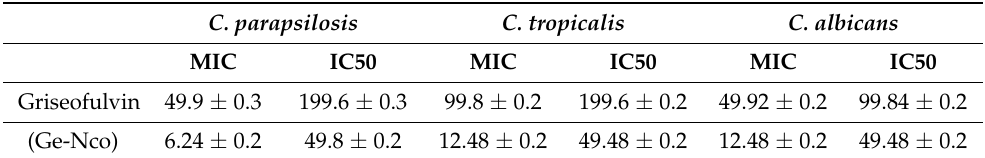
Table 1. Anti candida l susceptibility testing: estimation of the minimum inhibitory concentration (MIC) and the concentration of compounds required for 50% inhibition of germination (IC50) of all Candida